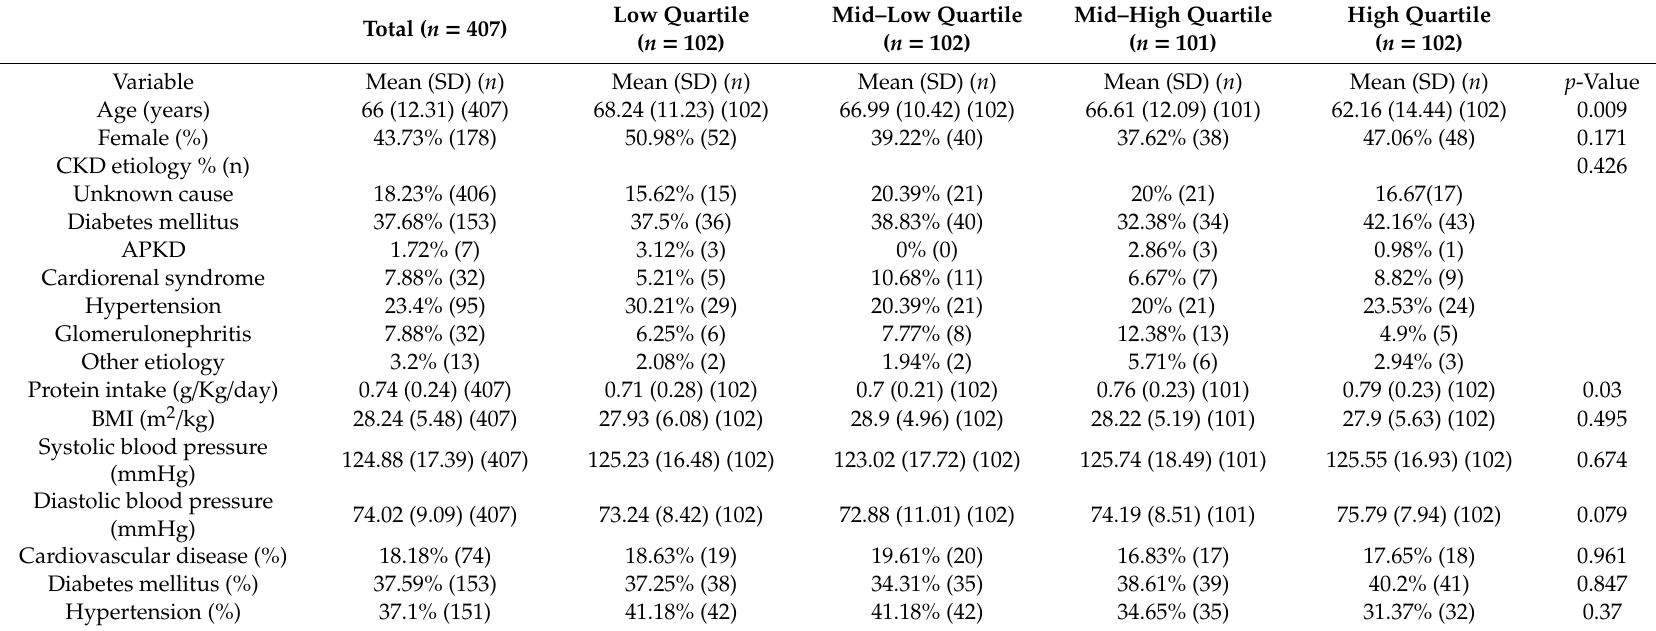
Table 1. Demographic, clinical, and laboratory characteristics of the study cohort according to quartiles of the fractional excretion of phosphate (FeP). BMI: body mass index, CKD: chronic kidney disease, PTH: parathyroid